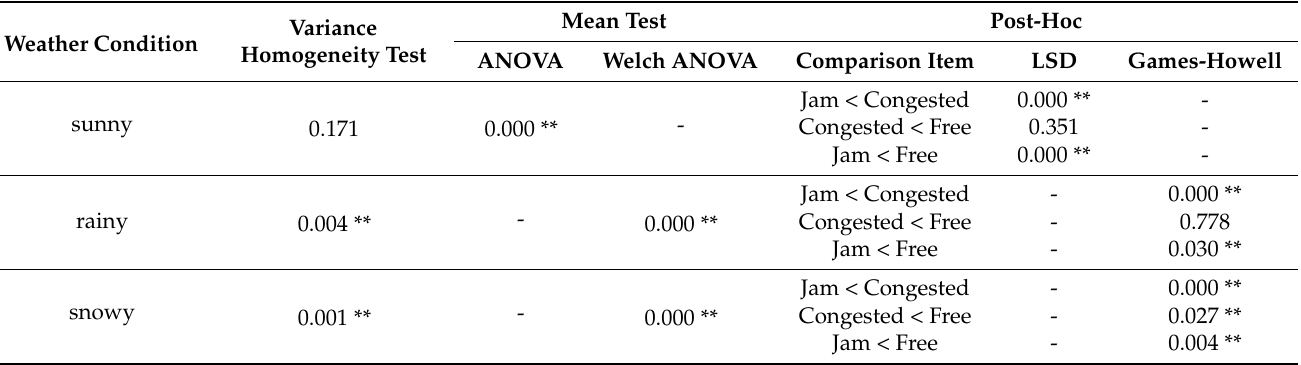
Table 10. The significance test of the effect of traffic flow on the standard deviation of